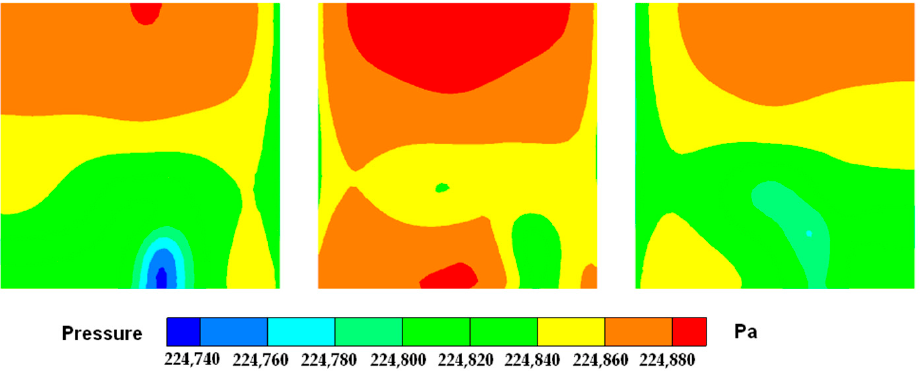
Table 2. Numerical analysis of inlet section under different schemes. Figure 15. Contour map of the inlet section pressure in the original scheme 0.